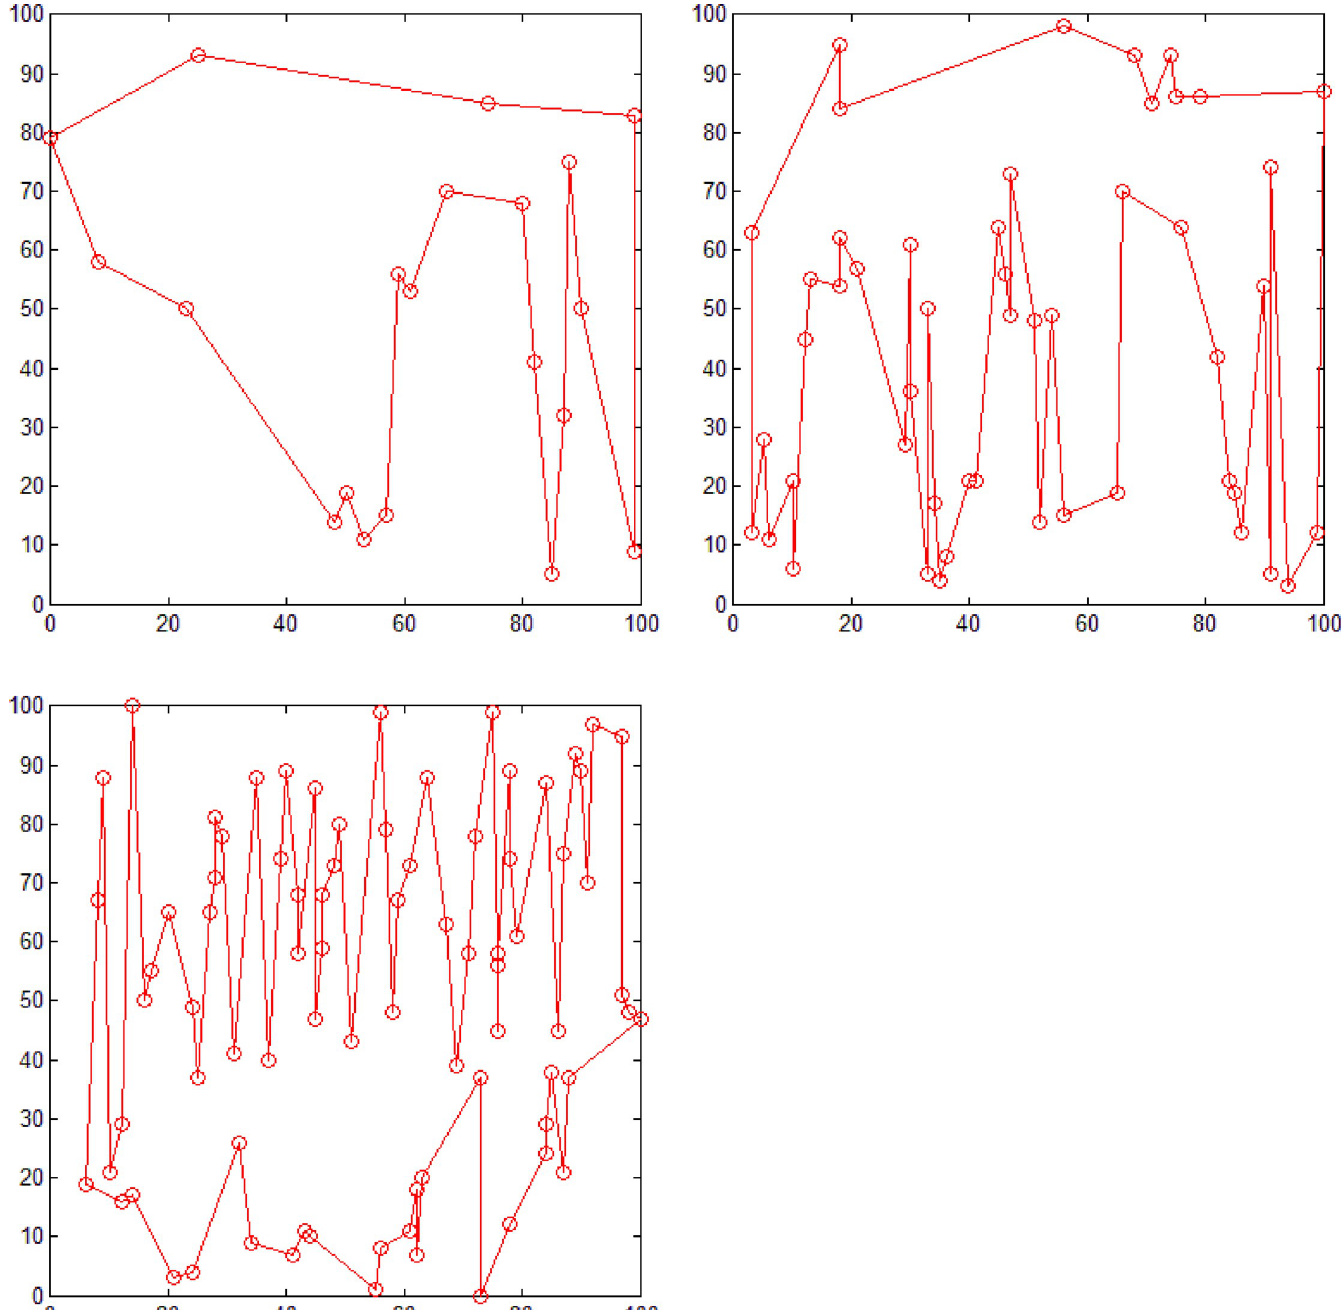
Fig 15. Polygon generating using the dichotomy sorting method. Polygon consisting of (a) 20 (b) 50, and (c) 80 points. https://doi.org/10.1371/journal.pone.0230342.g015 polar coordinate sorting method, where the black dot represents pole position. According to this algorithm, for a set of random points at a given position, this method can only generate a simple polygon with a fixed geometry. Fig 15 shows the result obtained using the dichotomy sorting method. It can be seen that the number of polygons generated is unique when the direction of a given dichotomy is fixed. However, the proposed method can still construct